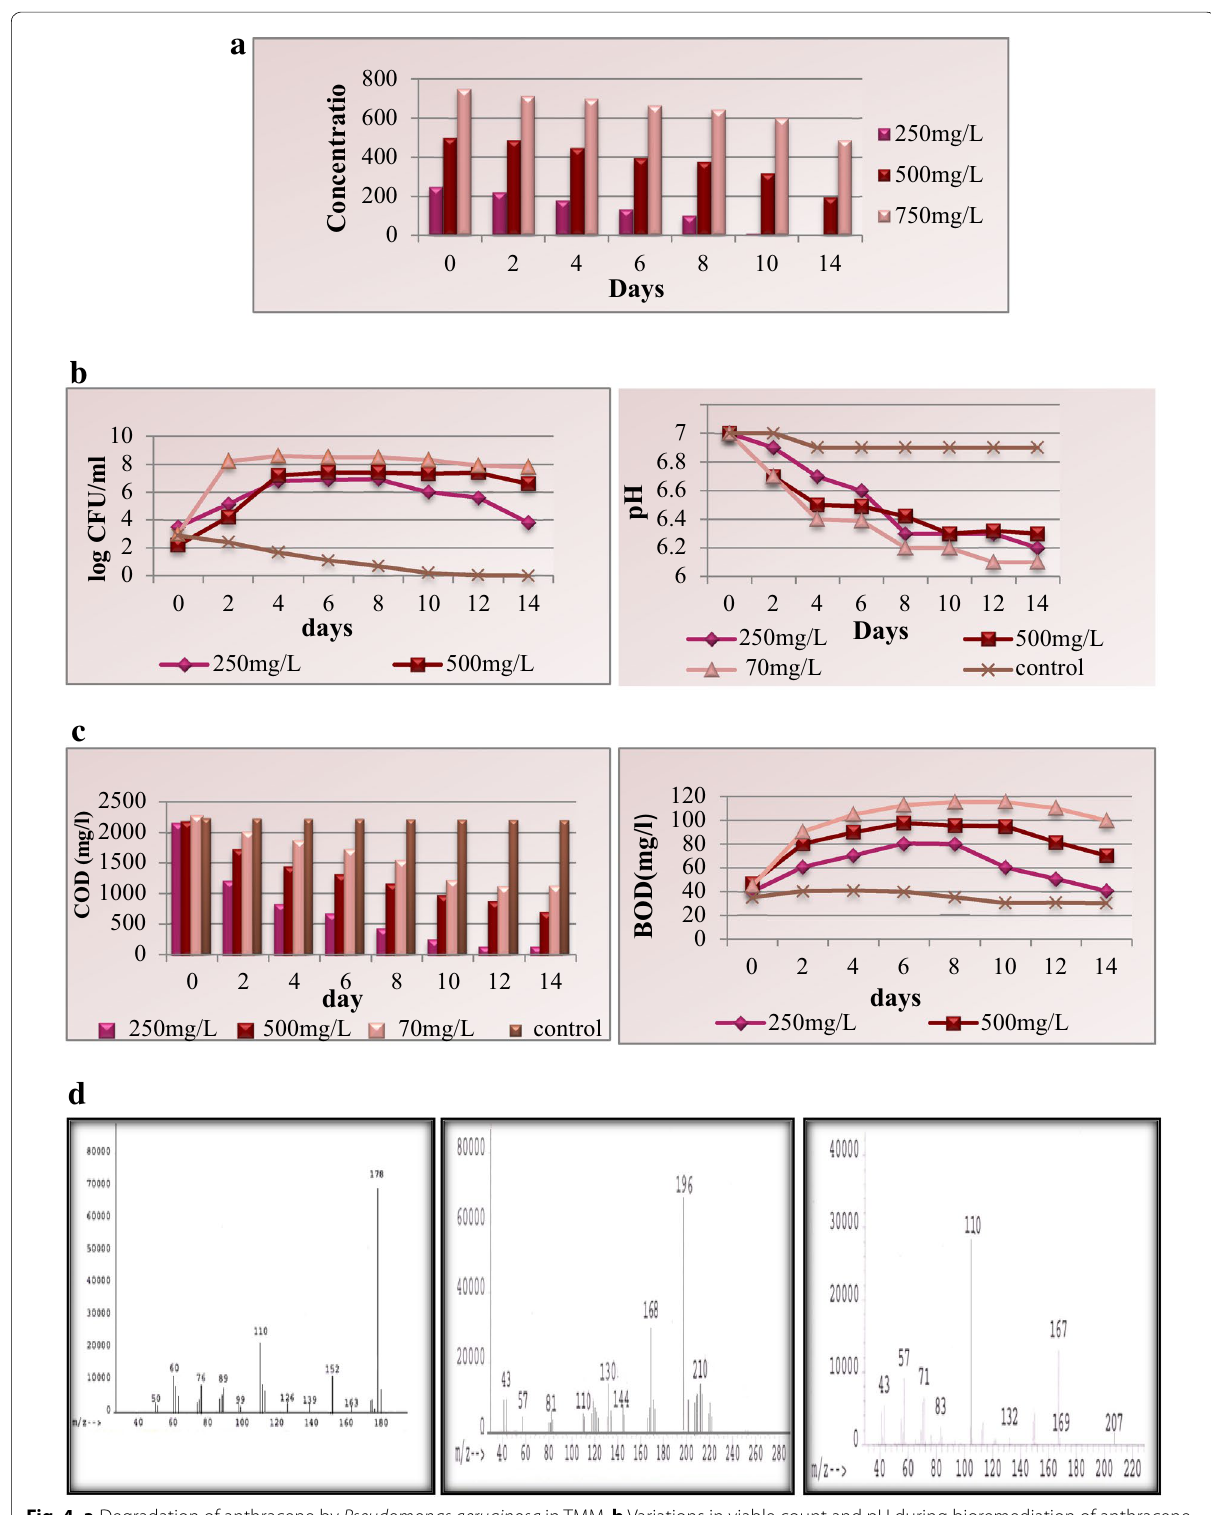
Fig. 4 a. Degradation of anthracene by Pseudomonas aeruginosa in TMM. b Variations in viable count and pH during bioremediation of anthracene by P. aeruginosa in TMM. c Variations in COD and BOD during bioremediation of anthracene by P. aeruginosa in TMM. d Mass spectrum of Anthra- cene ( m/z identification-178), benzocoumarin ( m/z identification-196, 168, 139), and catechol ( m/z